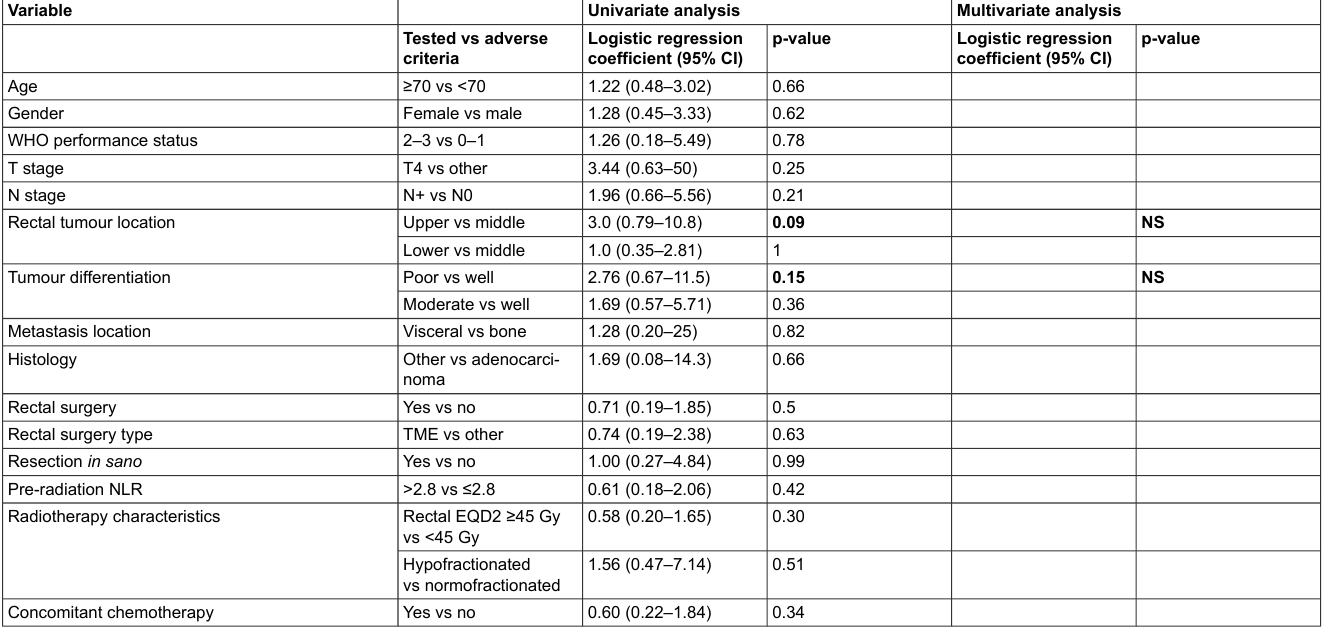
Table S1: Predictive factors for local relapse in the whole set of patients (n =